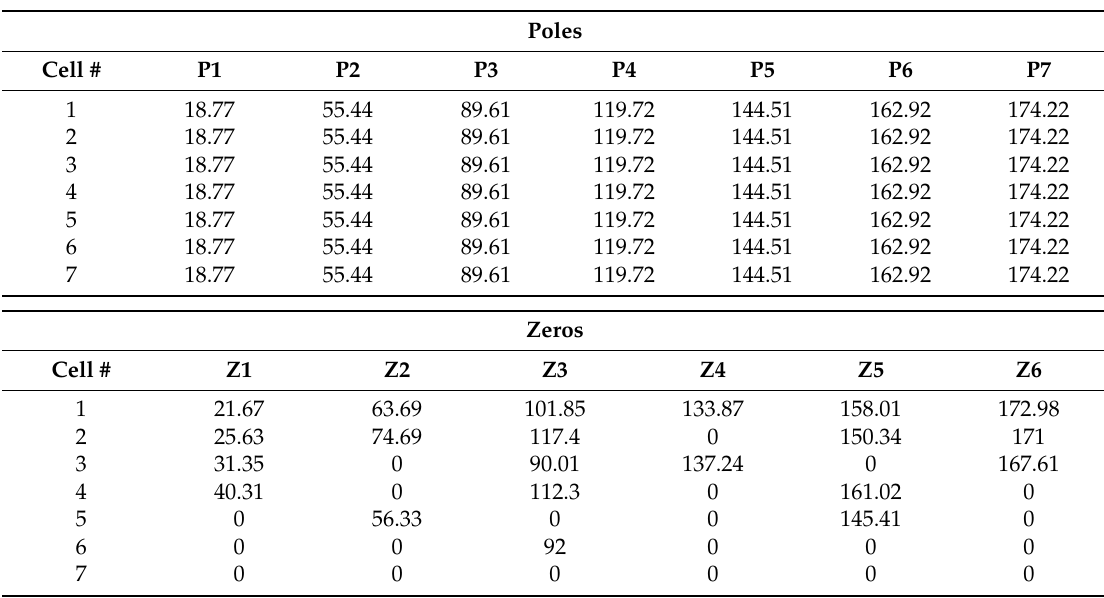
Figure 9. Comparison of the magnitude plots vs frequency of the patterns readable at the seventh node of the L–C L.N. when the capacitance at the 7th cell shifts from 47 nF to 44 nF.